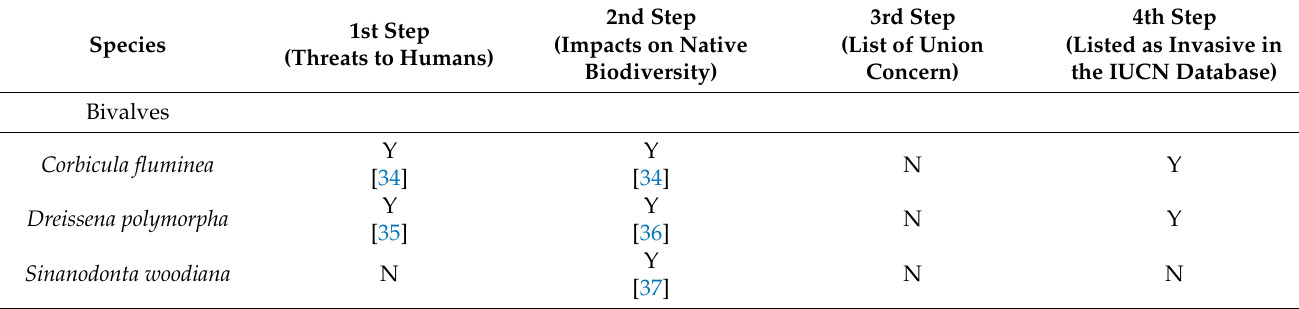
Table 2. Preventive analysis of the invasiveness level of the aquatic alien species listed in the catchment area of Lake Maggiore. N = no impacts, Y = with impacts. In brackets, we reported the literature collected about the impacts of the alien